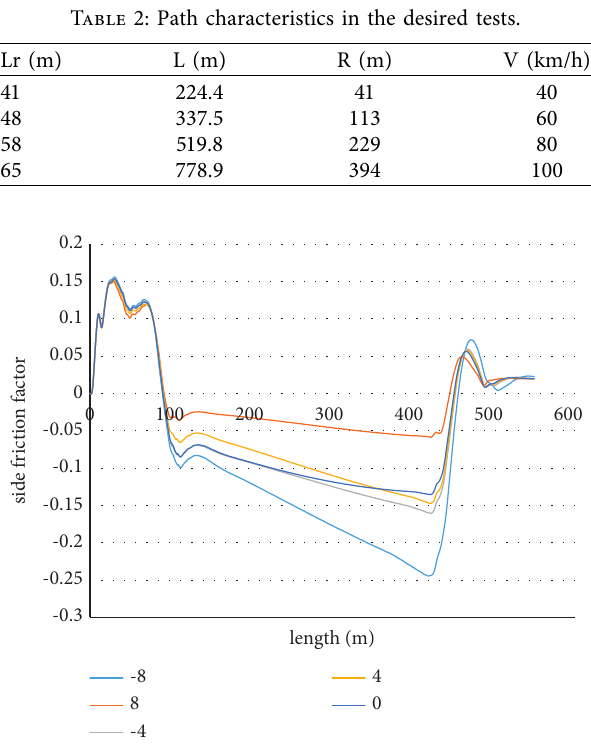
Figure 6: Comparison of coefficient of friction along the path at different slopes.